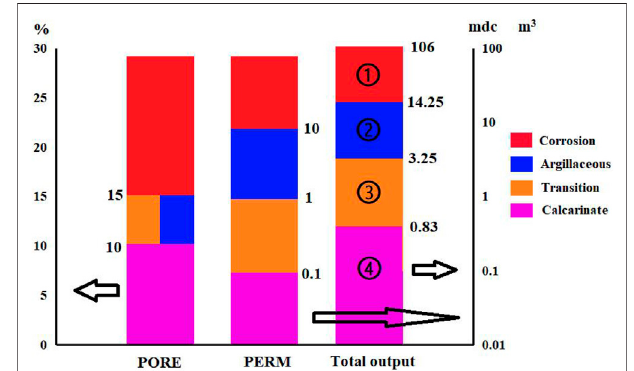
FIGURE 11 | Comparison of porosity and permeability distribution and productivity of different petrophysical facies in the Es 3 reservoir. (Note: Total output is the production, ① ② , ③ , and ④ , respectively, correspond to the four sub-layers in Figure 9 ; pore is the main coordinate axis, and its unit is %;PERM and total output are secondary coordinate axes, and the units are mdi and m 3 , respectively.)